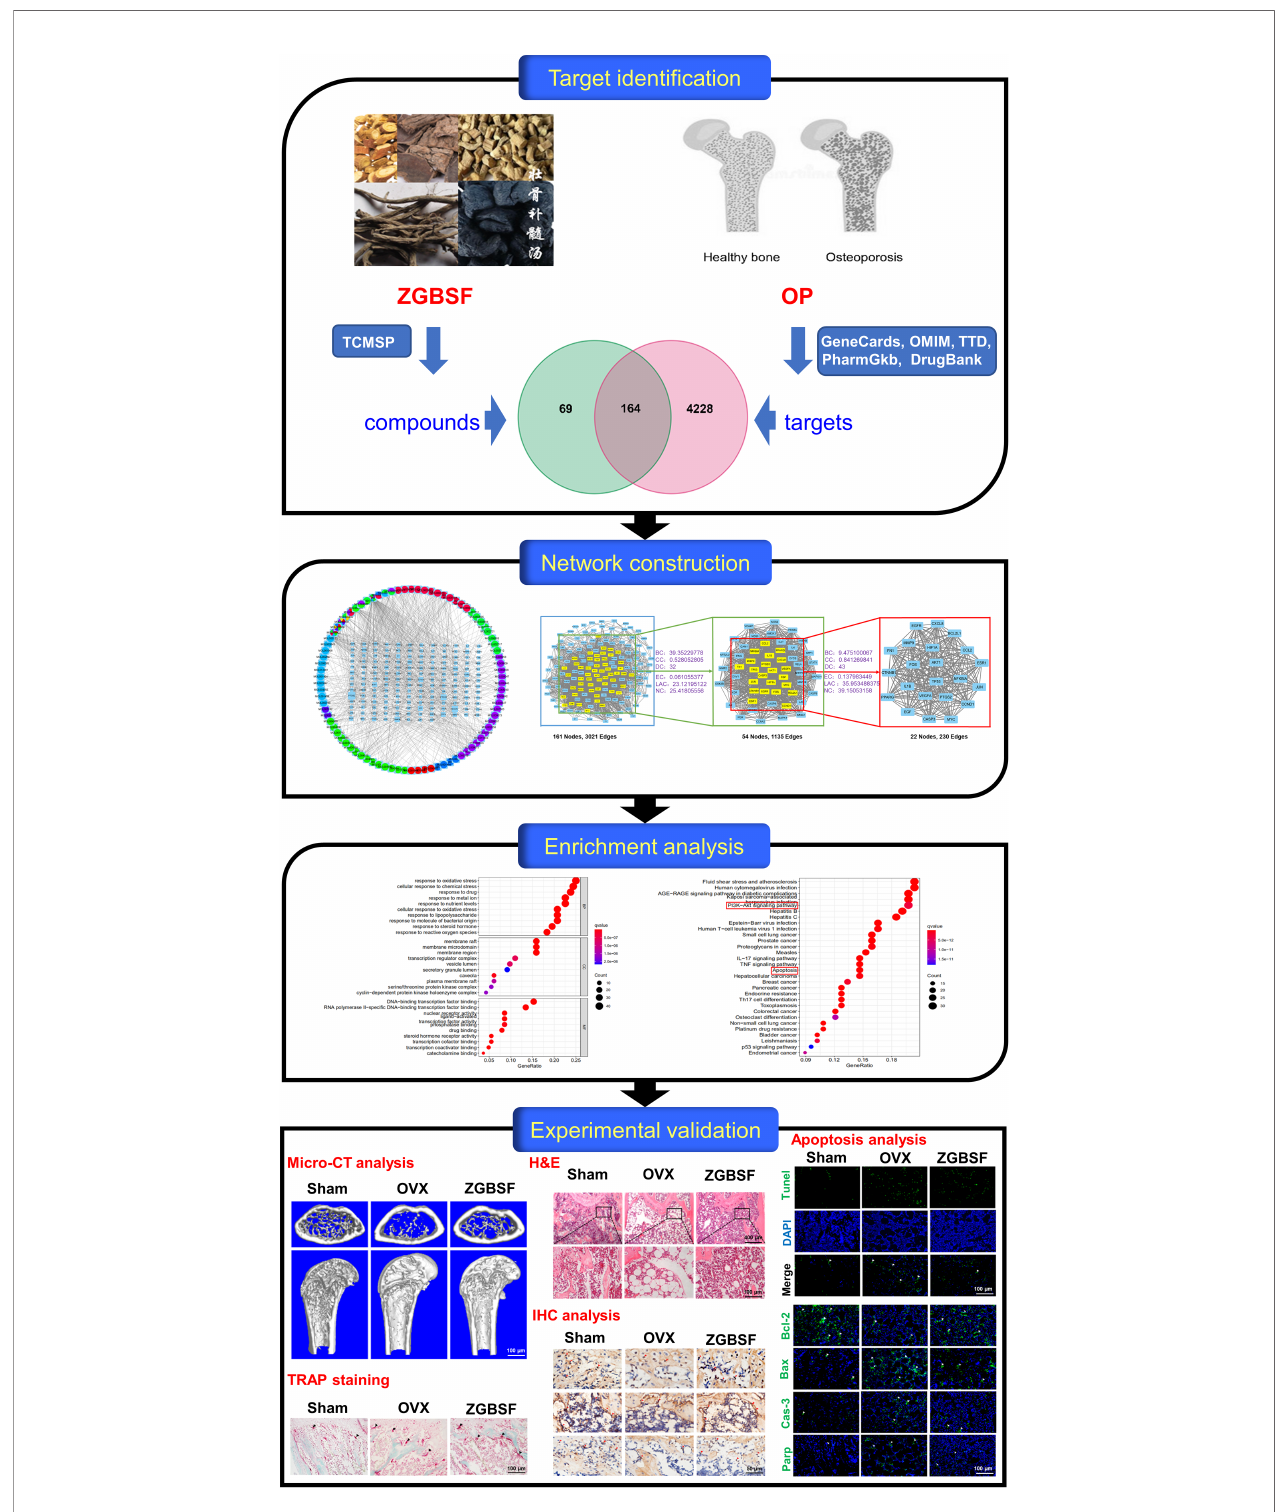
FIGURE 1 | A fl owchart for explaining the mechanism of ZGBSF against OP through targets identi fi cation, network construction, enrichment analysis, and experimental validation.